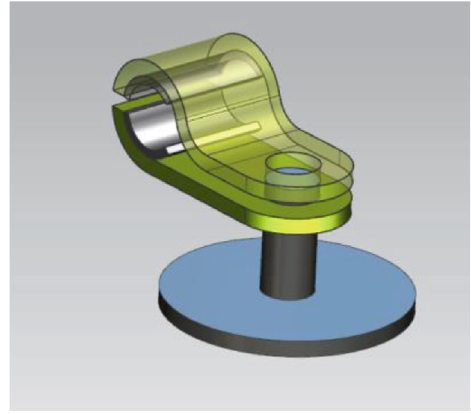
Figure 1: A simpli fi ed clamp CAD